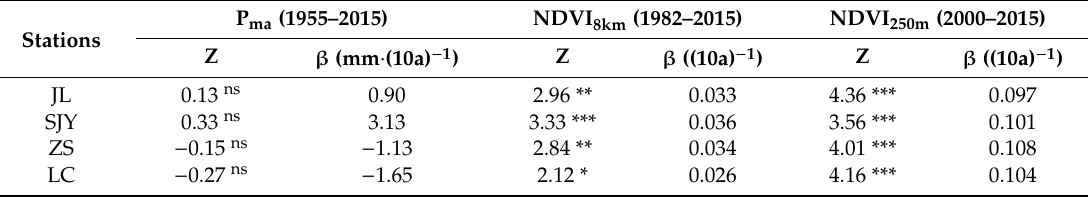
Table 4. Trends in influential variables revealed by the Mann–Kendall